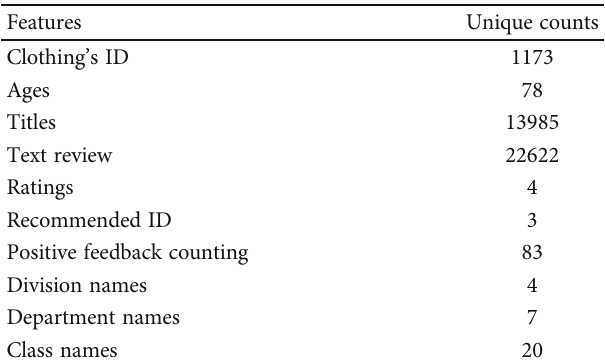
Table 2: Frequency distribution in women ’ s apparel datasets of selected features.